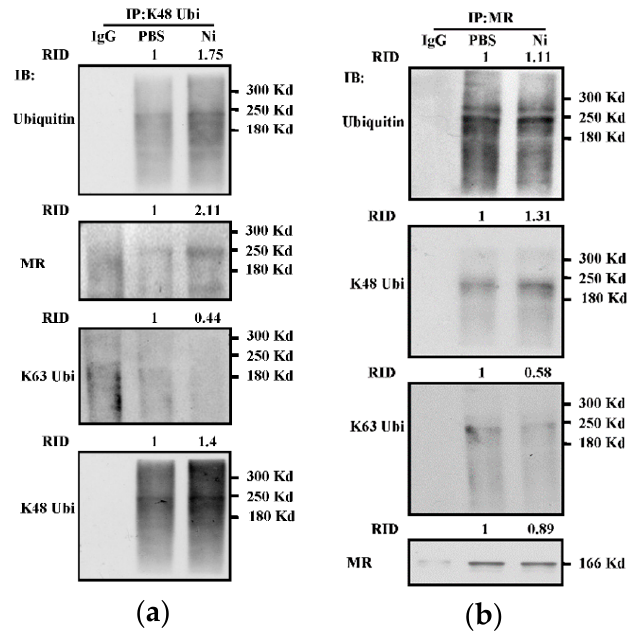
Figure 7. Nicotine increases K48-linked ubiquitination of mannose receptor in dendritic cells. ( a , b ) Murine BM-DC was stimulated with nicotine (10 − 7 mol/L) for 12~16 h. Whole cellular protein was extracted and Co-IP assay was performed with mannose receptor ( a ) or K48-linked ubiquiti- nation ( b ) antibody. The levels of mannose receptor, ubiquitination, K48-linked and K63-linked ubiquitination were determined by Western blot analyses. Protein level was quantified by ImageJ software and presented as related integrated density (RID). One representative from three indepen- dent experiments is shown. Ni: nicotine; K48 Ubi: K48-linked ubiquitination; K63 Ubi: